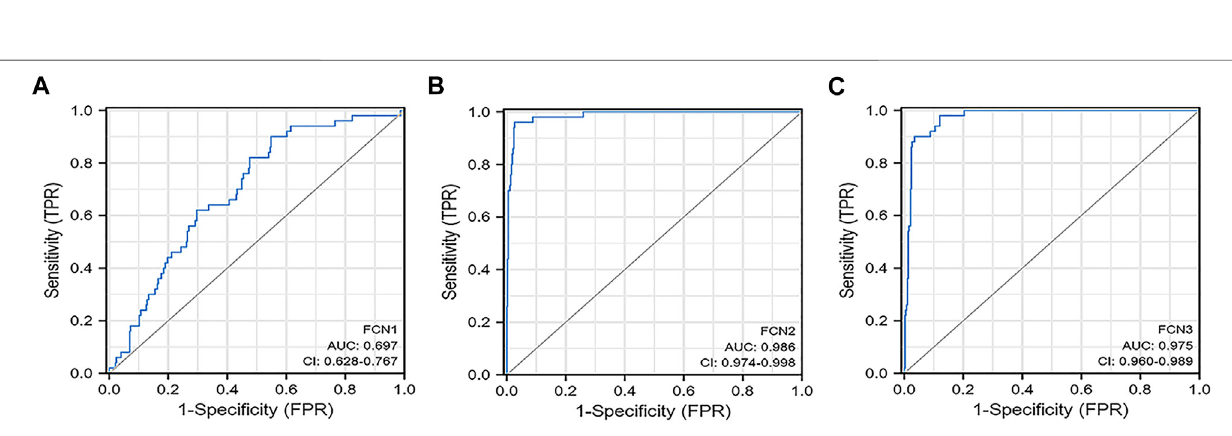
Frontiers in Genetics |